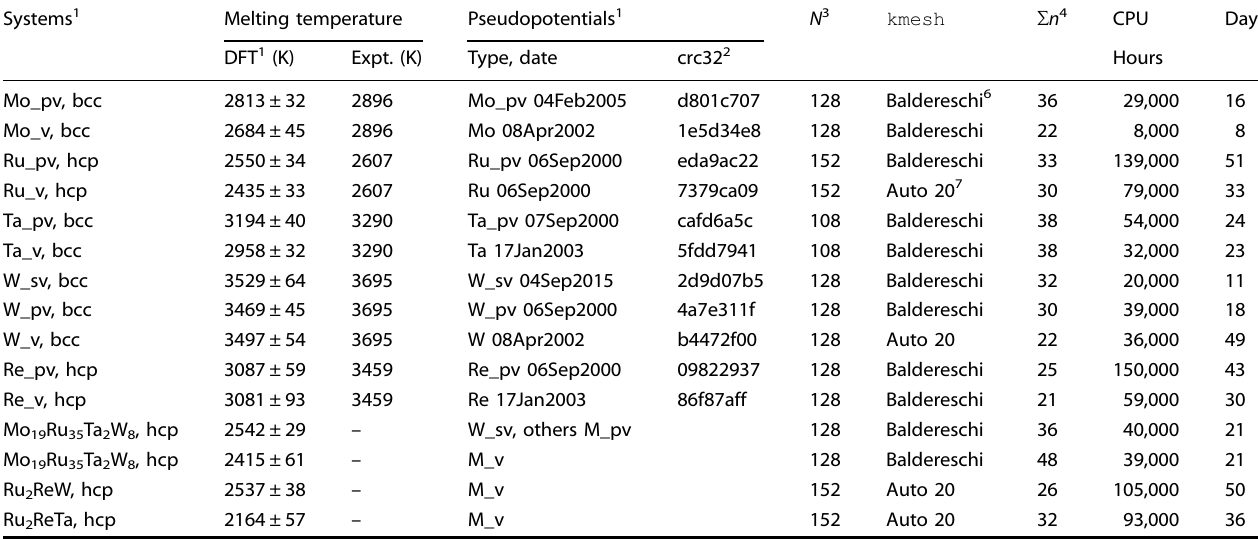
Table 1. Calculated melting temperatures, computational details and a comparison with